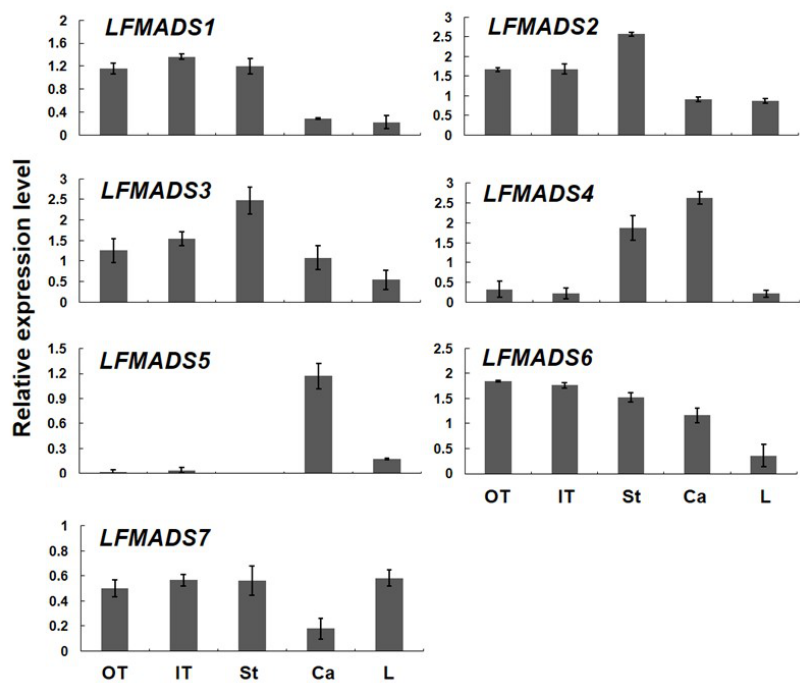
Figure 4. Quantitative analysis of seven LFMADSs gene expression in vegetative leaves and all four floral organs in L. formosanum . Total RNA was isolated from vegetative leaves and all four floral organs that were dissected from 2 cm flower buds in length, respectively. Real-time qRT-PCR analysis was performed for each collected sample and normalized with lily GAPDH (=1). Error bars indicate the standard deviation ( n = 3). OT: outer tepal; IT: inner tepal; St: stamen; Ca: carpel; L: mature leaf. Primers used in qPCR reactions are listed in Table S6.